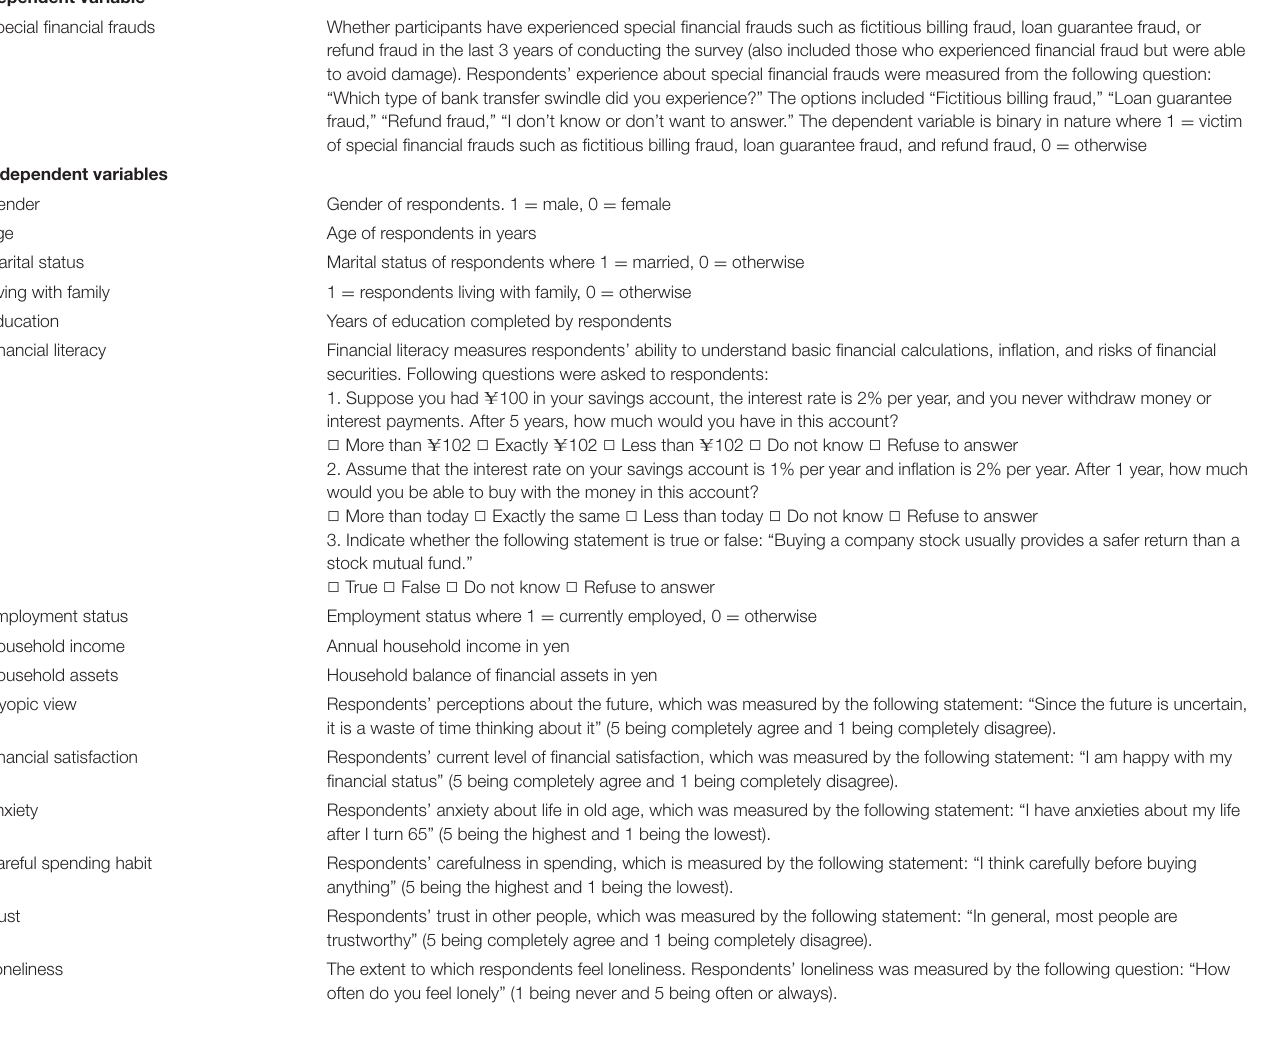
TABLE 1 | Definition and measurement of